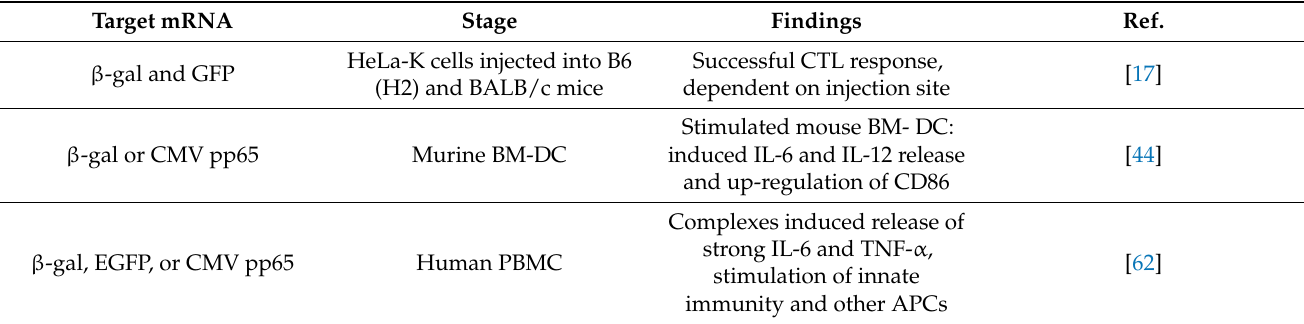
Table 1. Protamine-mRNA formulated